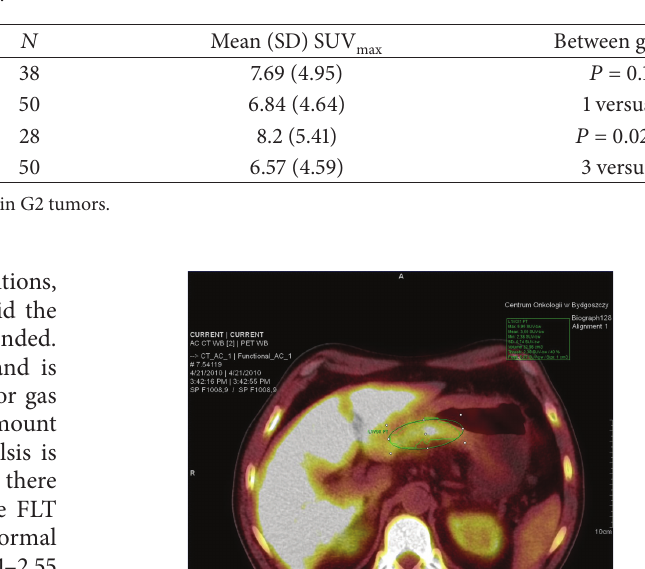
Table 3: The mean value of SUV (SD) in different cancer types, as divided according to Lauren classification and grading, compared to max whole population studied and between the individual groups.